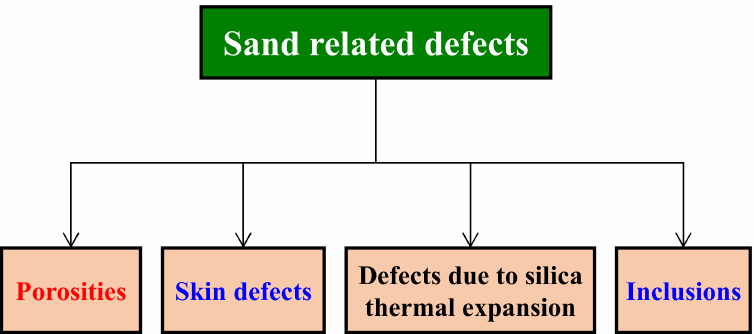
Figure 2. Casting defects related to sand.